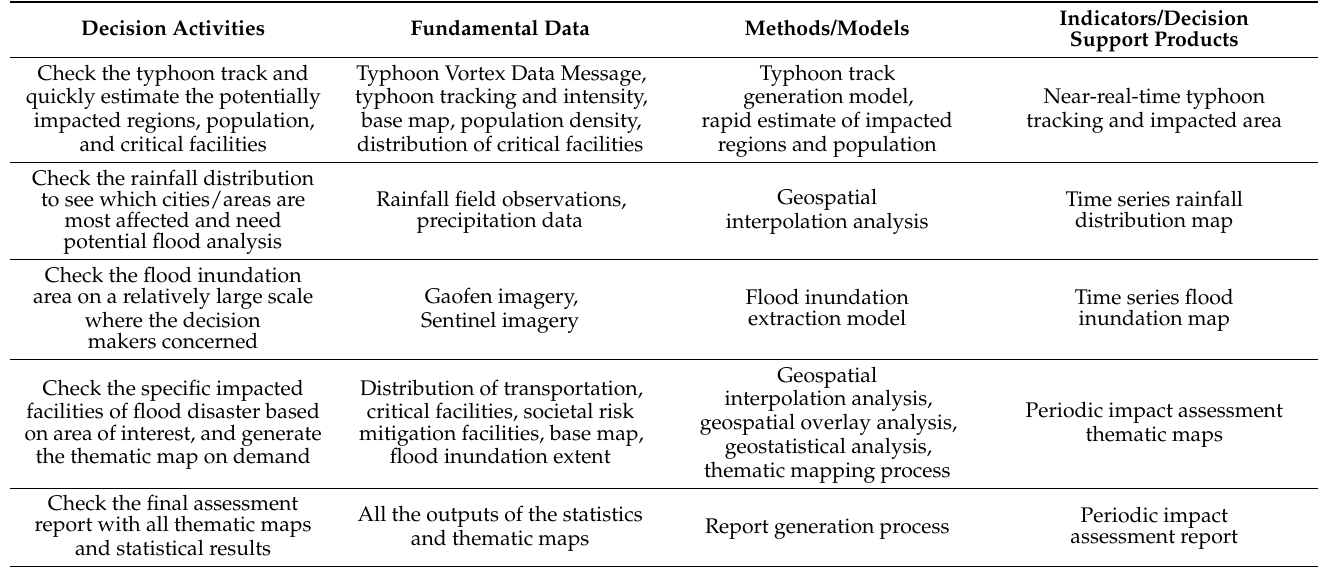
Table 2. Decision activities and relevant indicators after a typical typhoon-triggered flood disaster.